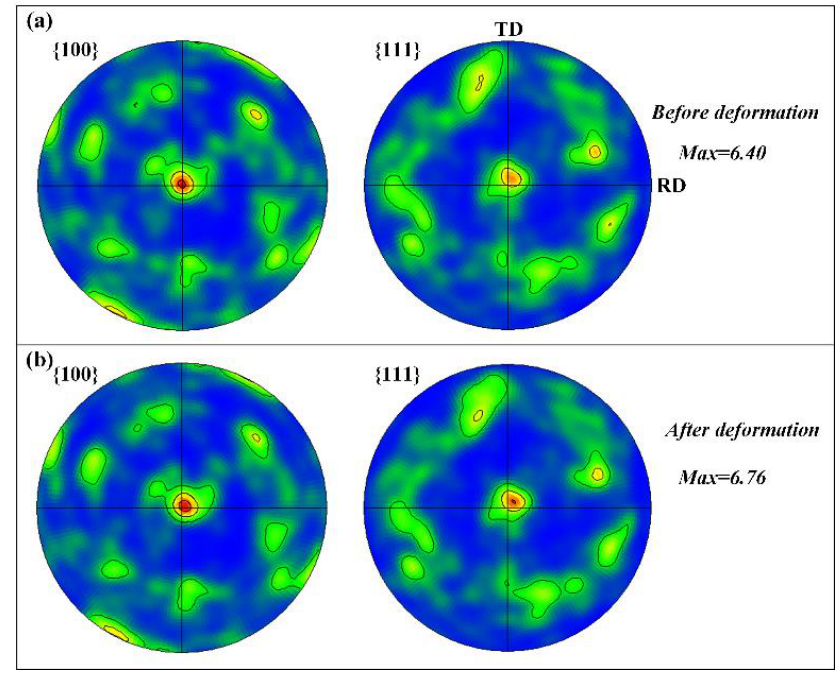
Figure 4. Pole figures (PFs) of the specimen ( a ) before compression and ( b ) after compression. During plastic deformation, the shape and textures of the polycrystalline metals change via grain rotation and subdivision. At the grain level, the shape and crystallographic orientation of each grain changed because of the lattice rotation. The orientation changes in each grain lead to the microtexture evolution upon the deformation process [10,15,16]. Thus, it is necessary to investigate the lattice rotation process in order to establish the relationship between the microtexture and the deformation parameters. Figure 5 shows the crystallographic orientation rotation degree of grains caused by compression. In particular, more than 180 grains were characterized in the scanning area, the Euler angles for grains before and after deformation were recorded, one by one, and then their rotation degree was calculated and labeled on the figure, respectively. It is found that grains with different crystallographic orientations have various rotation degrees. However, some grains with similar orientations show significant differences in their rotation